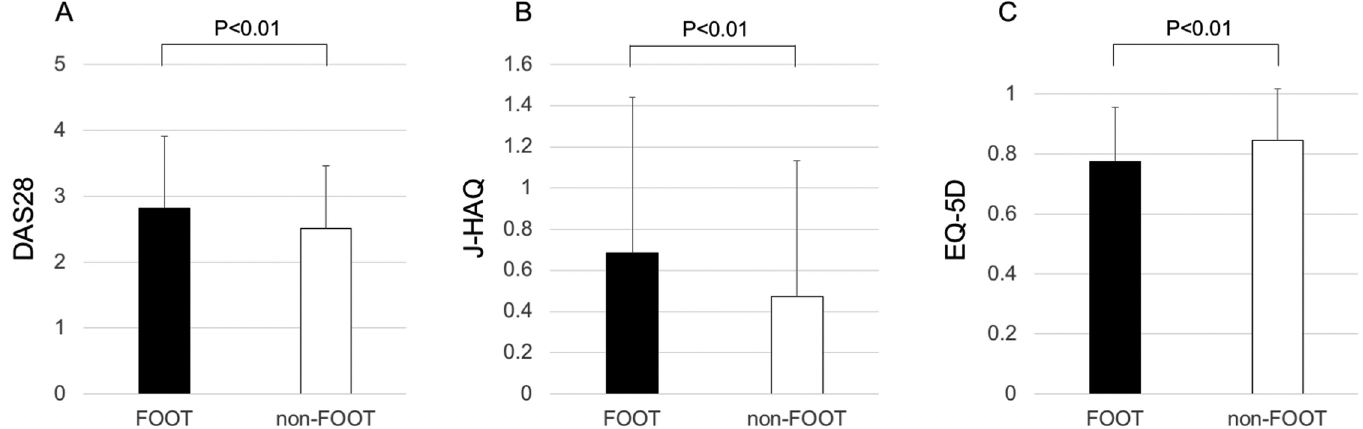
Fig 1. Bar graph showing the comparison of disease activity, functional disability, and quality of life between the FOOT and non-FOOT groups. A, Disease Activity Score in 28 joints calculated with ESR (DAS28). B, the Japanese version of the Stanford Health Assessment Questionnaire (J-HAQ). C, the EuroQol 5-dimensional descriptive system (EQ-5D).